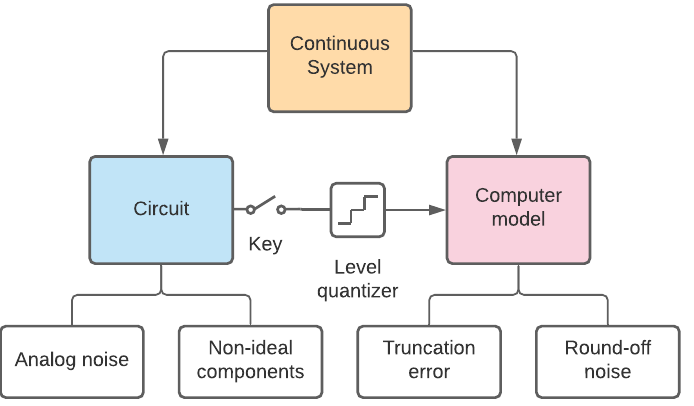
Figure 1. Sources of error in analog-to-numeric